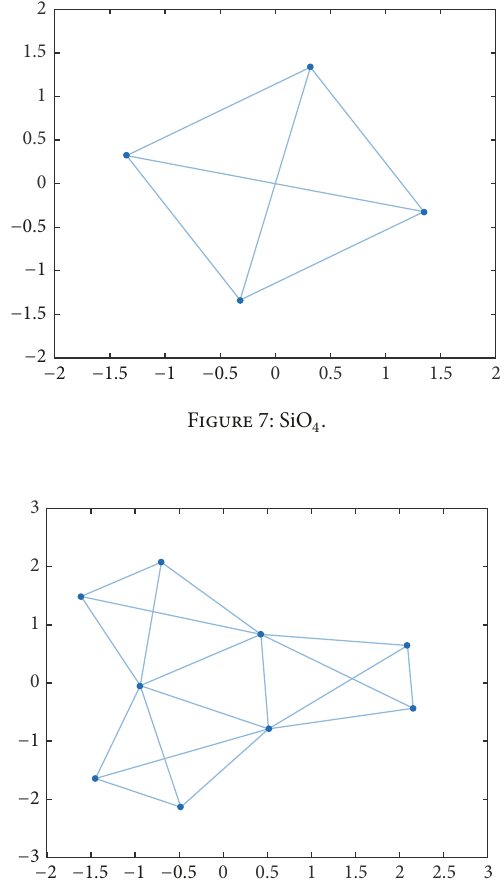
Figure 8: Triangular silicate network TsL(2).